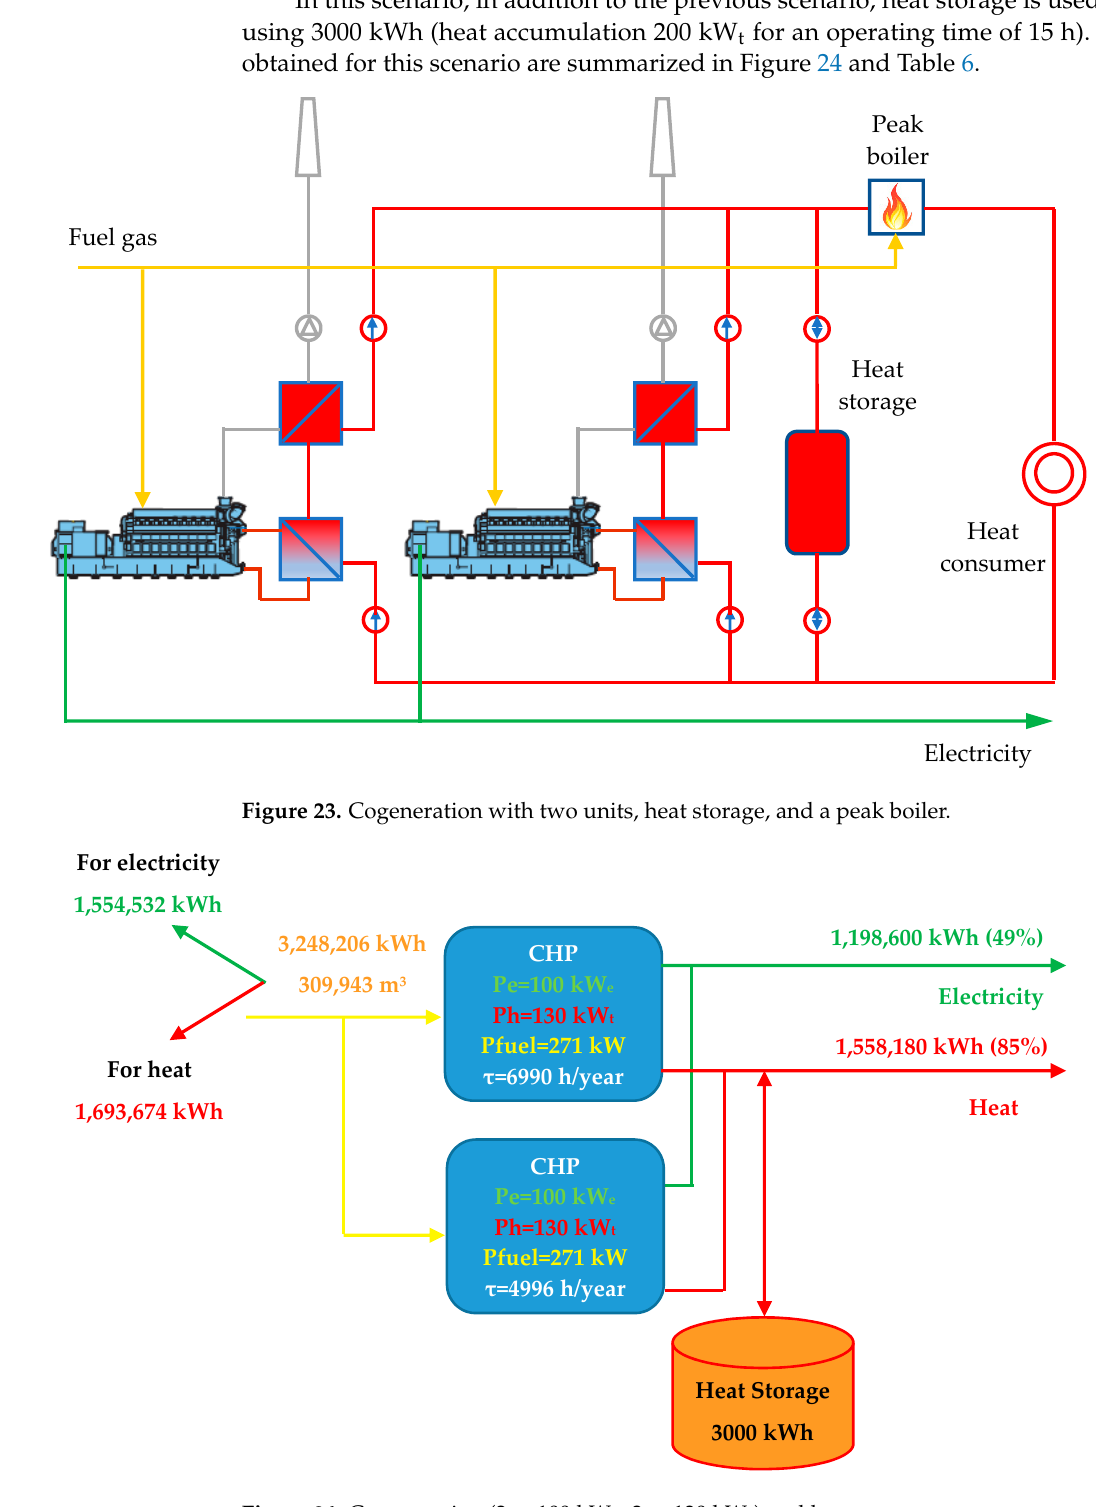
Figure 24. Cogeneration (2 × 100 kW e , 2 × 130 kW t ) and heat storage. Table 6. Cogeneration (2 × 100 kW e , 2 × 130 kW t ) and heat storage: summary results. U.M.